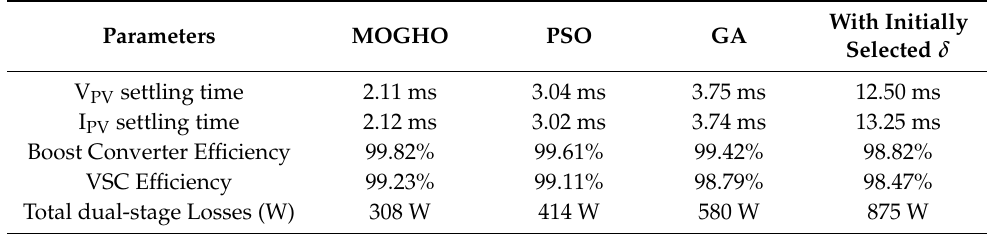
Table 1. MPPT, boost converter and VSC performance analysis during sudden irradiation level change.